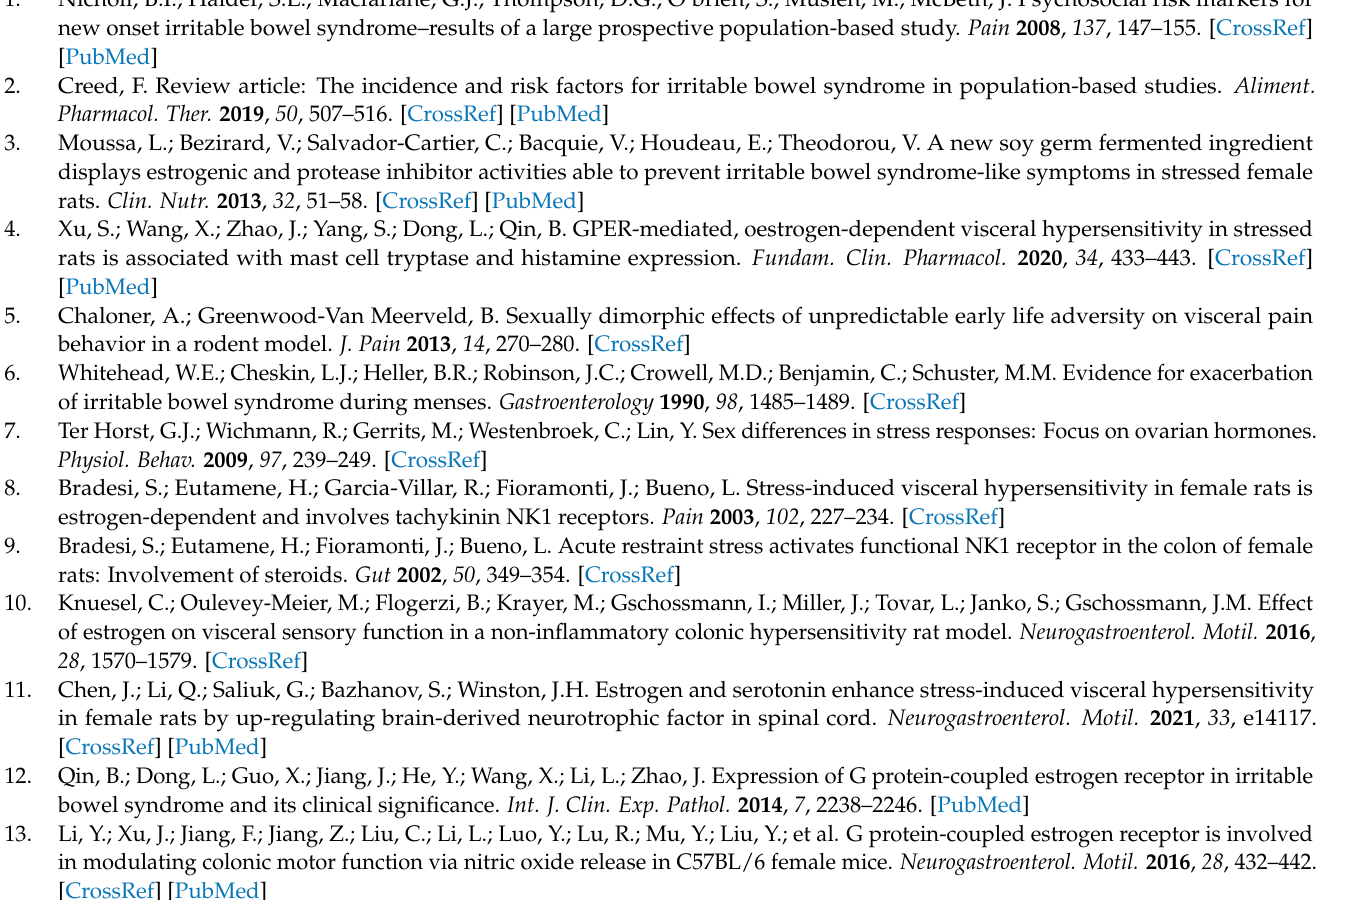
Table S1: qPCR primers. Table S2: Immune cells activation following ovariectomy in female and estradiol in